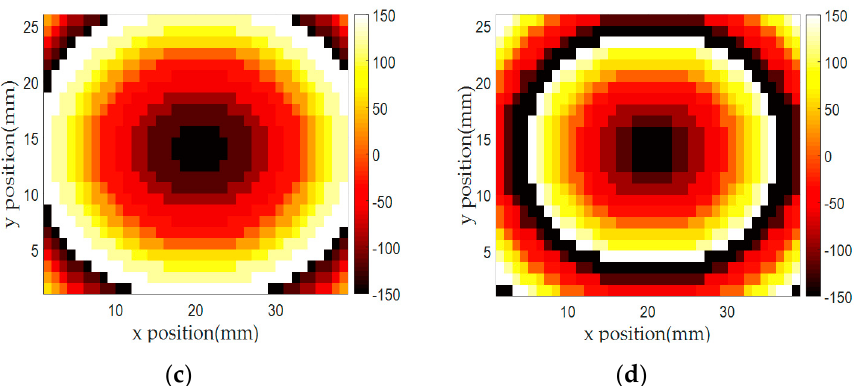
Figure 11. Required phase distributions calculated from Equation (5) of the focusing lens with ( a ) 100 mm and ( b ) 60 mm focal distances. Implemented phase distributions of the focusing lens with ( c ) 100 mm and ( d ) 60 mm focal distances.